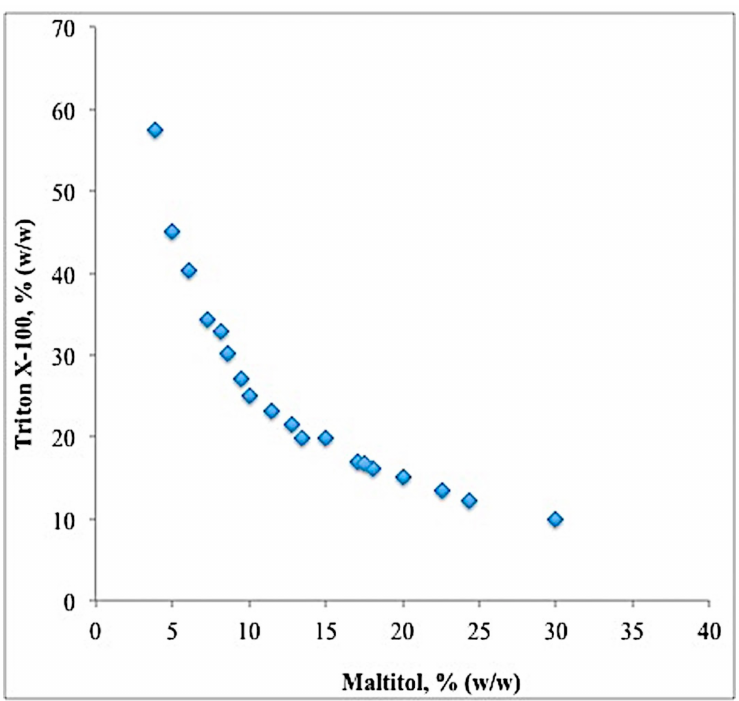
Figure 1. Binodal curve for ATPS composed of Triton X-100, maltitol and water at room